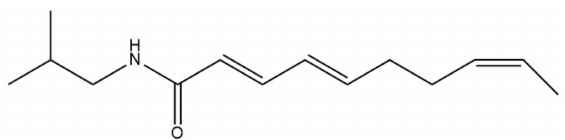
Figure 2. Chemical structure of 8,9- Z -dehydropellitorine.